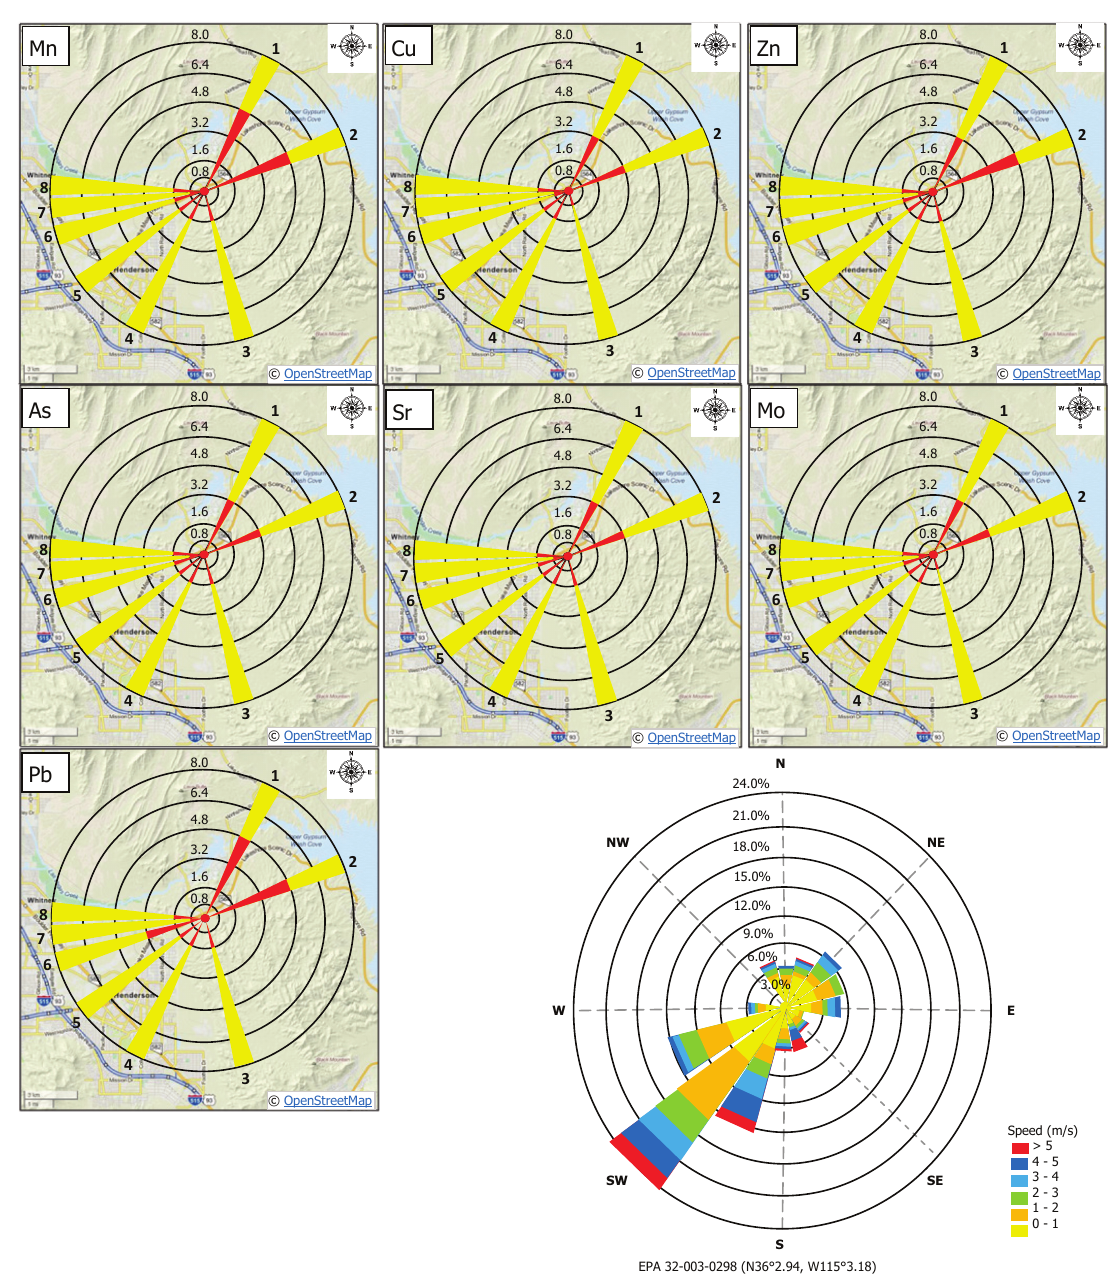
Figure 3. Transport diagrams of the chemical elements in the tailings of the Three Kids Mine. The yellow color begins closest to the tailings ponds, where the concentrations first drop to background levels.